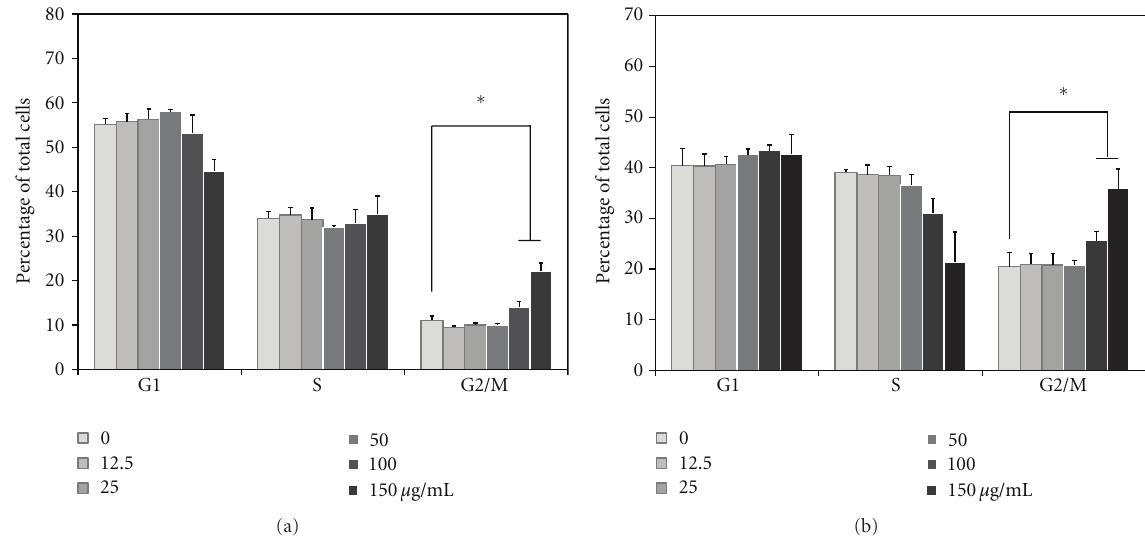
Figure 2: Cell cycle analysis of LCSP-treated CRC cells. Cells were treated with increasing concentrations of LCSP as indicated and then incubated at 37 ◦ C for 24 h. Cells were harvested and fixed in 70% alcohol and then stained with propidium. Stained cells were analyzed using a flow cytometer and the distributions in each cell cycle phase of Colo320DM (a) and SW480 (b) were determined using Modfit software. Data are expressed as a percentage of total cells, represent the averages of three independent experiments, and are expressed as the mean ± SD. ∗ Represents a significant di ff erence ( P < 0 . 05).